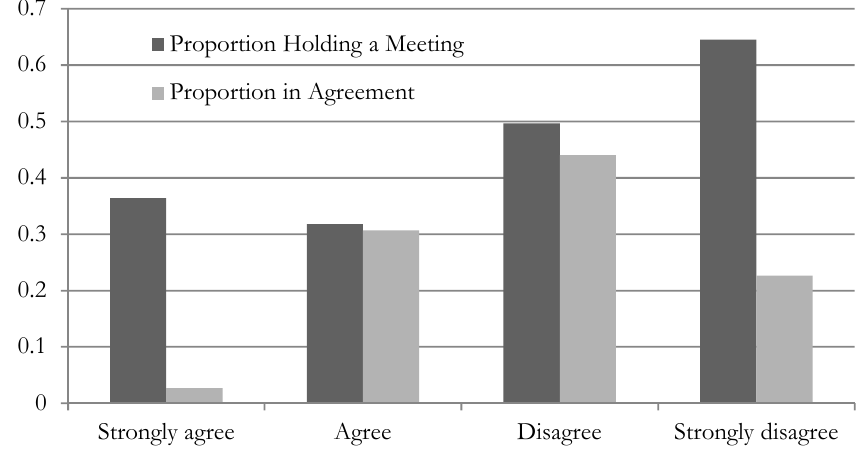
Figure 1 : Distribution of Congregational Meetings across Congregational Agreement with the ELCA Vote (also showing the distribution of perceived congregational agreement with the